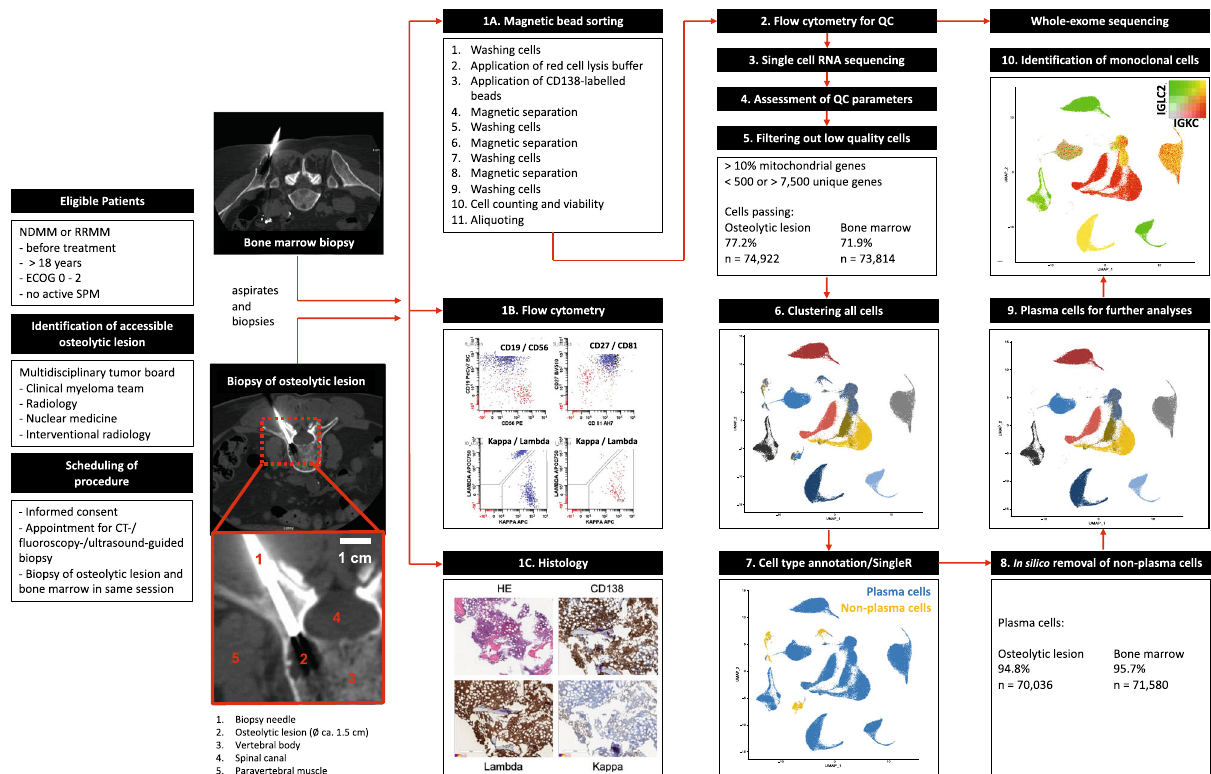
Fig. 1 Acquisition of viable plasma cells from imaging-guided biopsies of osteolytic lesions and bone marrow. Eligible patients with newly diagnosed (NDMM) or relapsed/refractory multiple myeloma (RRMM) were discussed in a multidisciplinary tumor board before the initiation of therapy. Patients consented to an imaging-guided biopsy of an osteolytic lesion (OL) in addition to the routine diagnostic bone marrow aspirate from the iliac crest (BM). To minimize changes in gene expression due to delayed sample processing, aspirates of the BM and OL were performed and analyzed on the same day as follows: (1A) Plasma cells (PC) were isolated using CD138 positive selection; Clinical samples were investigated by fl ow cytometry (1B) and immunohistochemistry (1C) to con fi rm the diagnosis 2 Fluorescence-activated cell sorting (FACS) was performed for quality control (QC) 3 ; cells were subjected to single cell RNA sequencing (scRNA-seq). The rest of the PC were frozen at − 80 °C and later analyzed by whole exome sequencing (WES). After assessment of QC parameters 4 , low quality cells were fi ltered out 5 . Standard Seurat work fl ow was performed to cluster all cells 6 . After identi fi cation of contaminating non-malignant PC (yellow, PC in blue) 7 the respective cells were removed in silico 8 for further analyses 9 . Malignant PC were identi fi ed by restricted heavy and light chain expression 10 . QC parameters were comparable between OL and BM and ca. 95% of captured and sequenced cells from BM and OL were PC underlining feasibility of our work fl